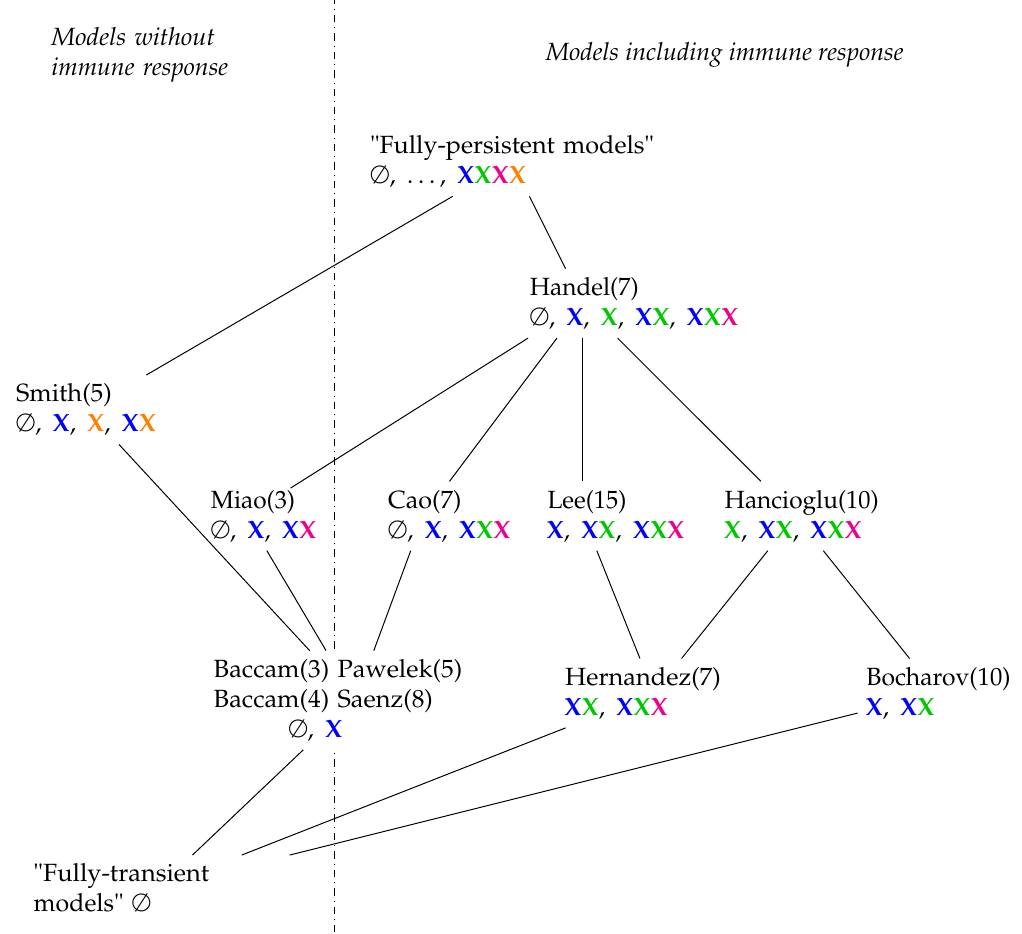
Figure 15. Hasse-diagram of the hierarchy of IAV models with respect to their long-term behaviour. In brackets (), we added the number of species of each model. Underneath (marked by colors) the kinds of species contained in the organizations belonging to each model. The meaning of the four colors is as follows: Species belonging to the healthy state of the organism are colored blue, those belonging to the immune response are colored green, those belonging to infection like infected cells and viruses are colored magenta, and bacteria from bacterial co-infection are colored orange. Horizontally, the diagram consists of four lines. The models in the lowest line contain organizations with exactly two different kinds of species (colors) (including the empty set). In the second line above, there are three different combinations of species (colors) to be found in each model. There is only one model in each of the highest two lines: The Smith model [4] is the only one with bacteria and contains four different combinations of colors. In the Handel Model, there are even five different combinations of colors out of 2 4 = 16 possible